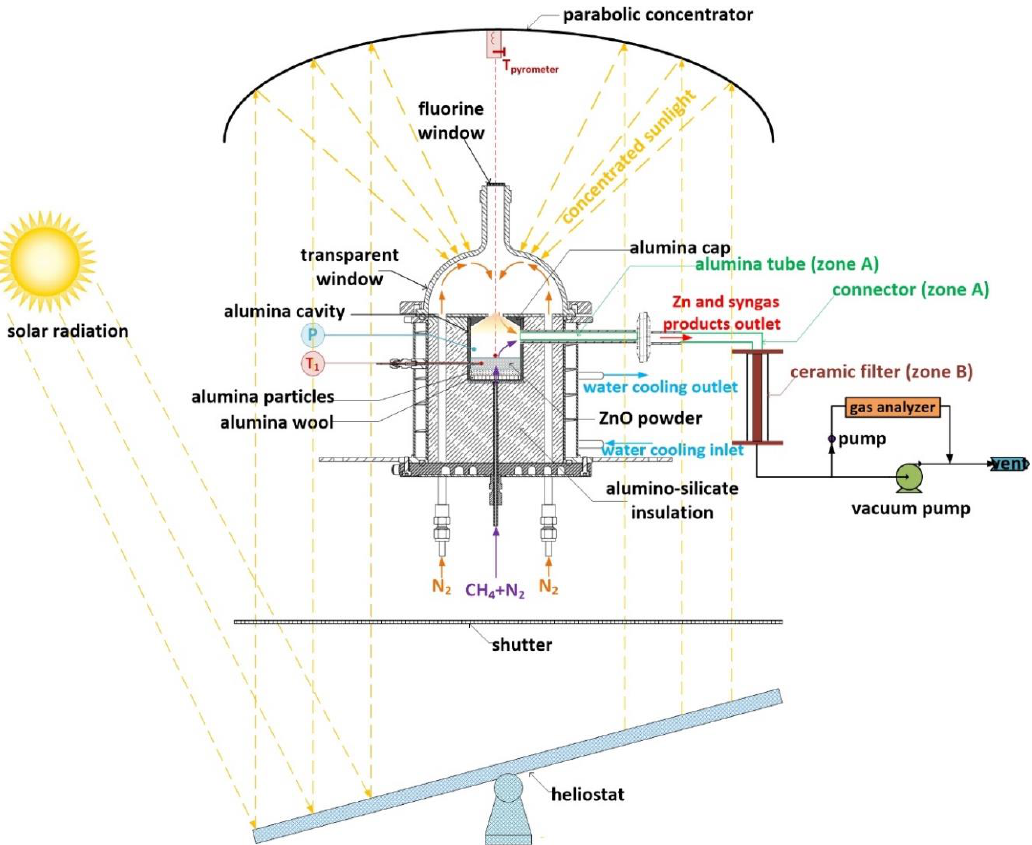
Figure 11. Schematic diagram of solar furnace and complete experimental set up. Source: reprinted from Chuayboon and Abanades [29], Copyright (2021), with permission from Elsevier.